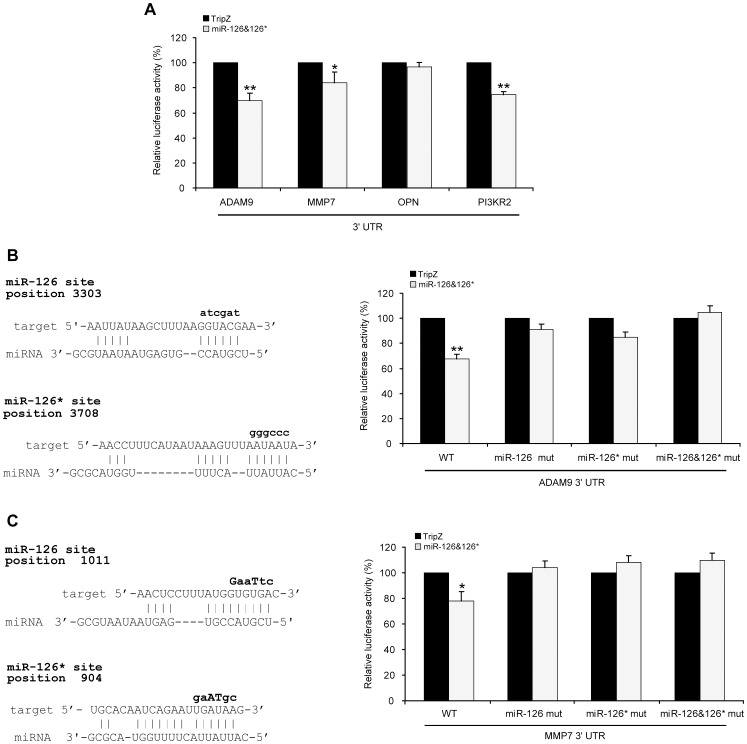
Luciferase Assays of miR-126&126* target genes.
A) Luciferase reporter assays performed by transfecting a Luc reporter gene (psiCHECK2) linked to 3′-UTR of ADAM9 or MMP7 or OPN or PI3KR2 in miR- versus empty vector-transduced A375M cell lines. B) Schematic presentation of predicted miR-126 and miR-126* target sites identified in the ADAM9 3′UTR (left) and relative miR-126&126*-dependent luciferase activities (right) in presence of wild-type (WT) or mutant (mut) binding sites in the-ADAM9 3′UTR. C) The same schematic representation (left) and luciferase experiments (right) carried out on MMP7 3′UTR. Columns, of minimum of 5 experiments per group; **P<0.001; *P<0.05.